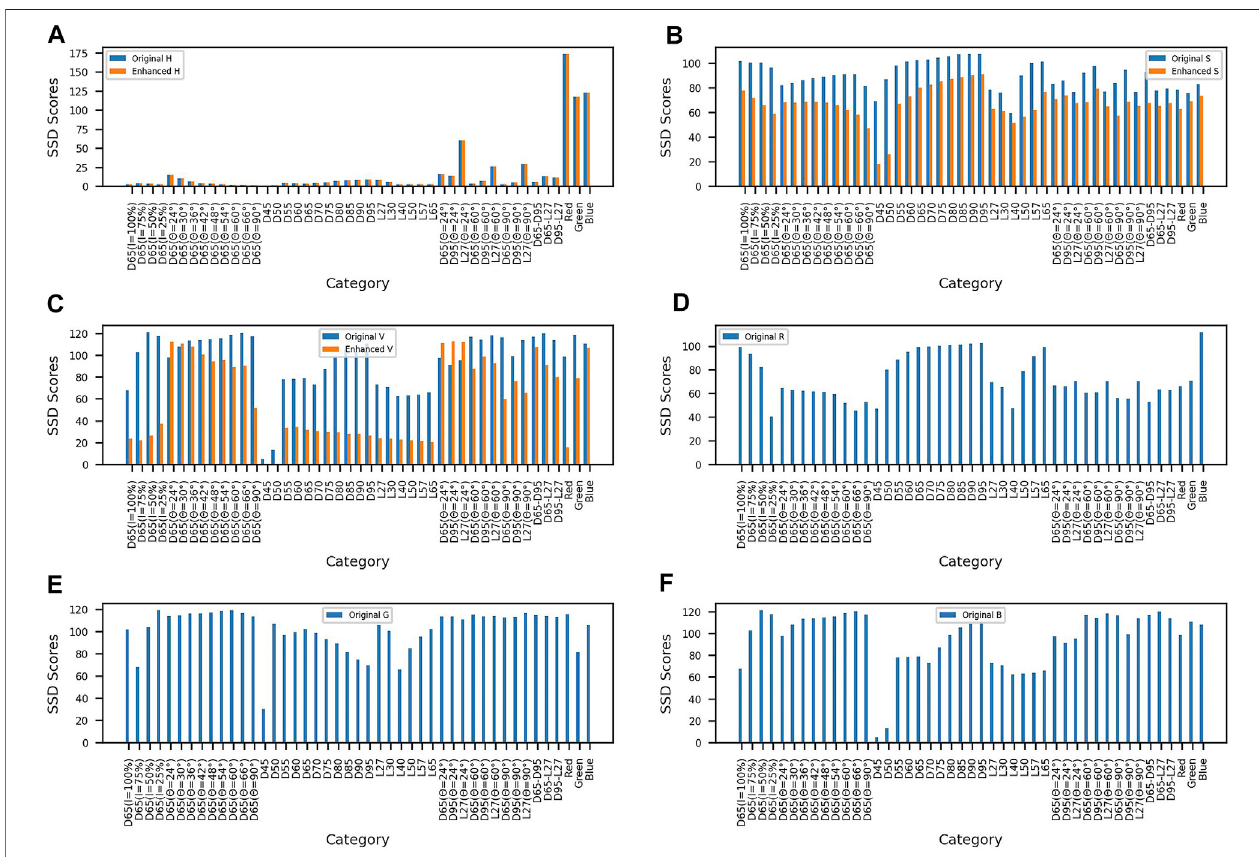
FIGURE 4 | SSD contrast fi gure. (A) Comparison between the original hue and enhanced hue. (B) Comparison between the original saturation and enhanced saturation. (C) Comparison between the original value and enhanced value. (D) Original red channel. (E) Original green channel. (F) Original blue channel.